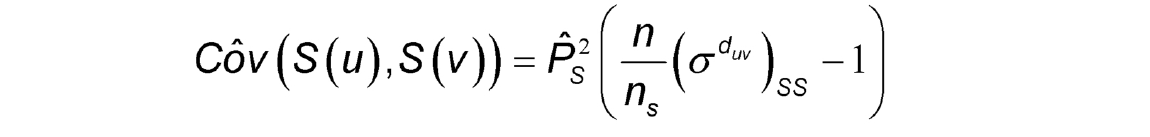
Figure 1. Equation for covariance between sample units in a chain-referral